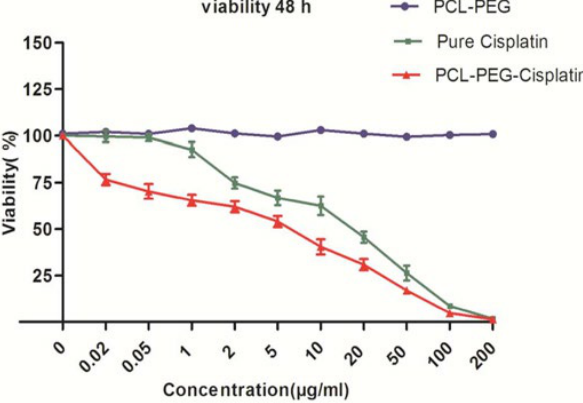
Fig. 6.b: The results of treatment with dilutions of block copolymers, pure and copolymer containing cisplatin in 48 hours.